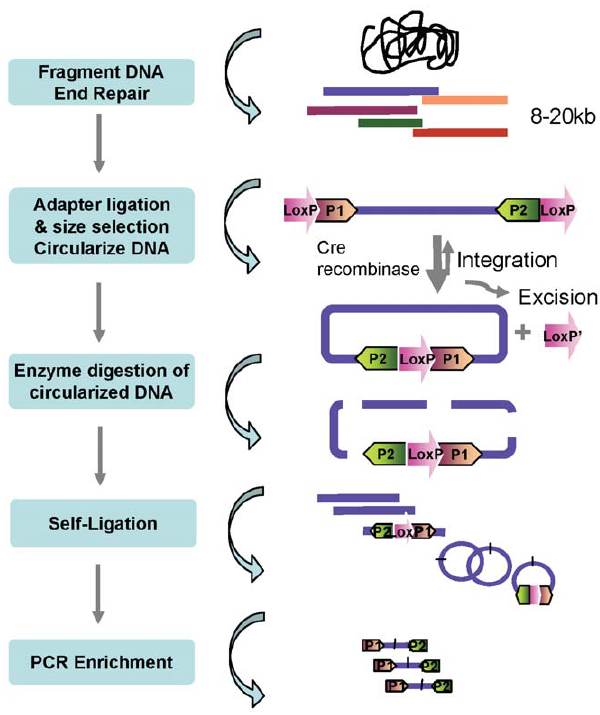
Figure 1. A schematic representation of the CLIP-PE library construction strategy. Following fragmentation, the DNA molecules are end-repaired and ligated with LoxP-P1 and LoxP-P2 adaptors integrated with Illumina P1 or P2 sequences. After separation and size selection, DNA is circularized by Cre recombinase, and non-circularized DNA is removed by exonuclease digestion. bp enzyme cutter is then used to digest and fragment DNA. (Alternatively, circularized DNA can be fragmented by random shearing to 400–500 bp followed by end- repair). DNA is then self-ligated. Inverse PCR with Illumina P1 and P2 PCR primers is used to enrich the mate paired molecules for sequencing. The final prepared libraries consist of short fragments made up of two DNA segments that were originally separately by 5–